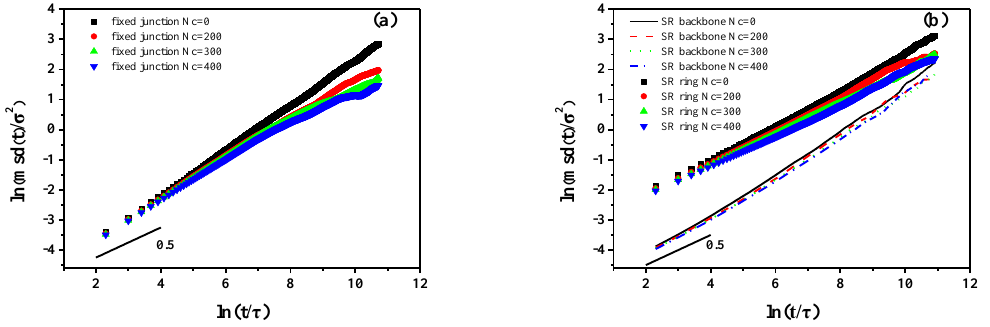
Figure 2. The mean-square displacement (MSD) of ( a ) backbone in fixed junction systems and ( b ) backbone and ring structure in SR systems. The black lines with slope of 0.5 are shown as a guide for the eye.